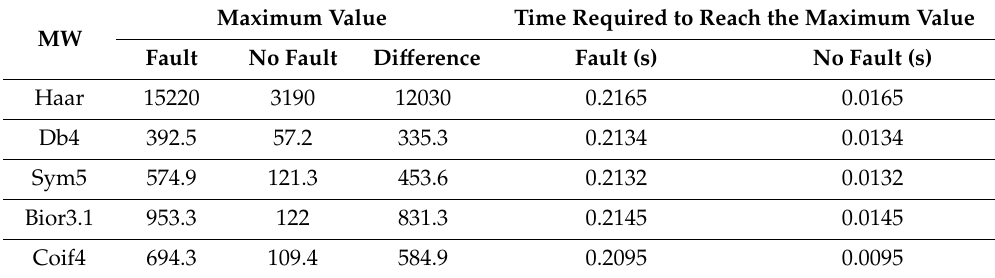
Table 1. Comparison of simulation results. MW = mother wavelet.